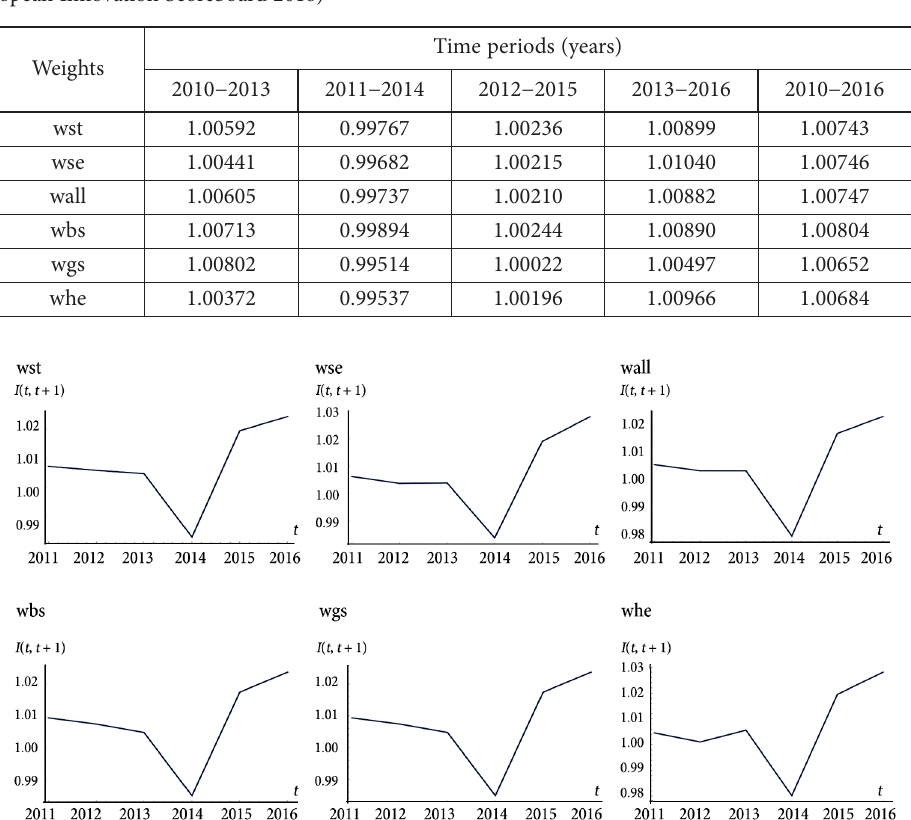
Figure 2. The one-year innovativeness changes depending on the system of weights and calculated for the EU-15 (source: own elaboration based on the data of the European Statistical Office – Eurostat and European Commission, 2018. European Innovation Scoreboard 2018) than in the entire EU and an upward trend from 2014